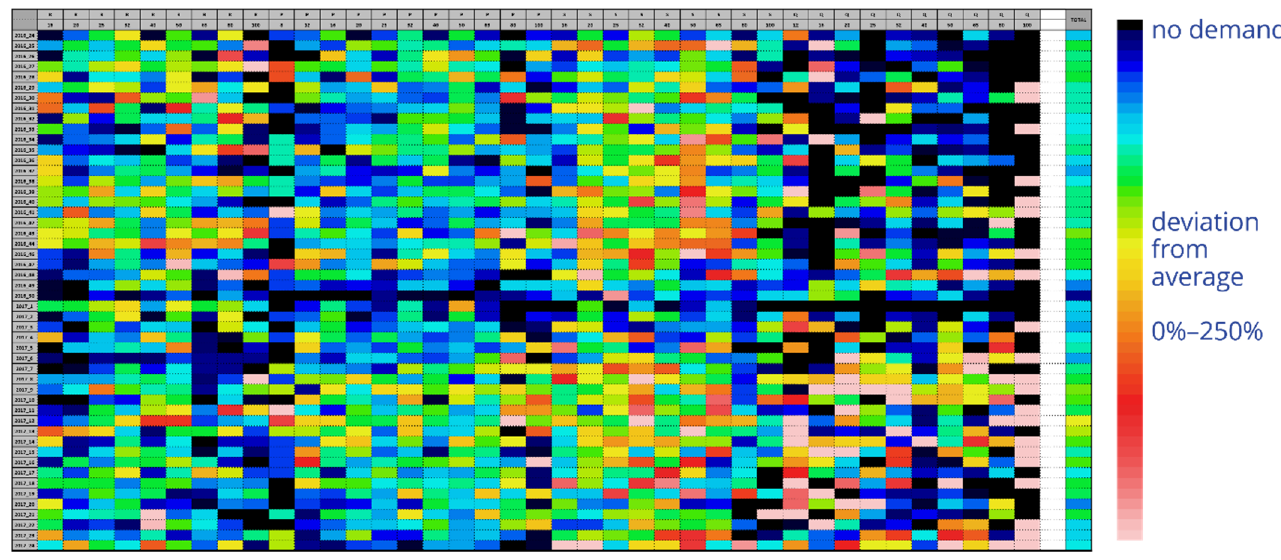
Figure 3. Typical HMLV demand mix: weekly aggregates over a year.